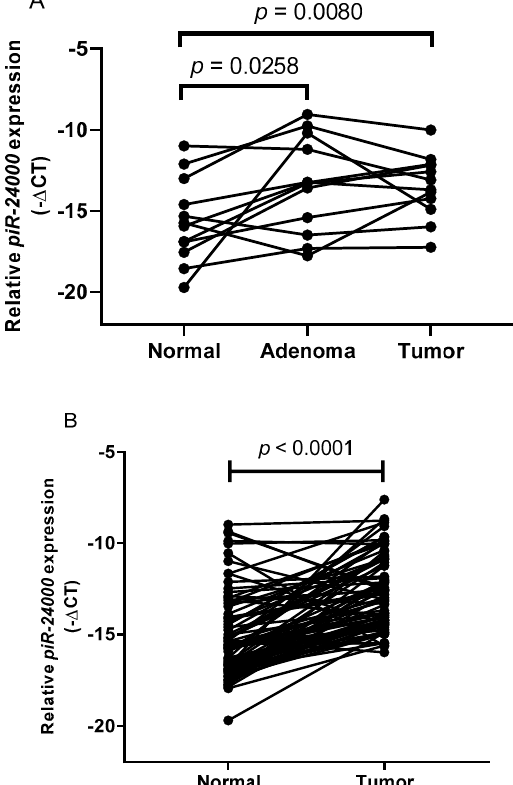
Figure 3. piR-24000 is overexpressed in CRC. Real-time PCR-based expression analysis of piR-24000 in ( A ) matched CRC, adenoma, and normal colon tissues from 12 patients, ( B ) matched CRC and adjacent normal colonic mucosa from 87 patients. Expression of piR-24000 was normalized to RNU6B and expressed as −∆ Ct (negative delta Ct).